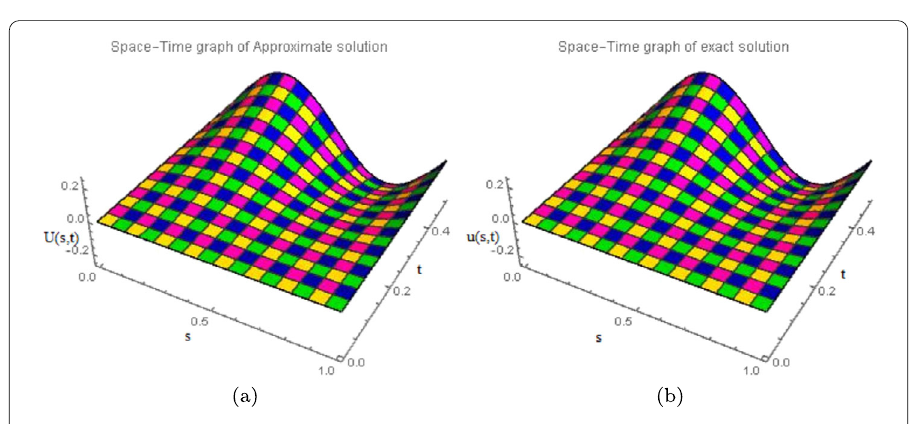
, t = 0.5 for Example 2 60